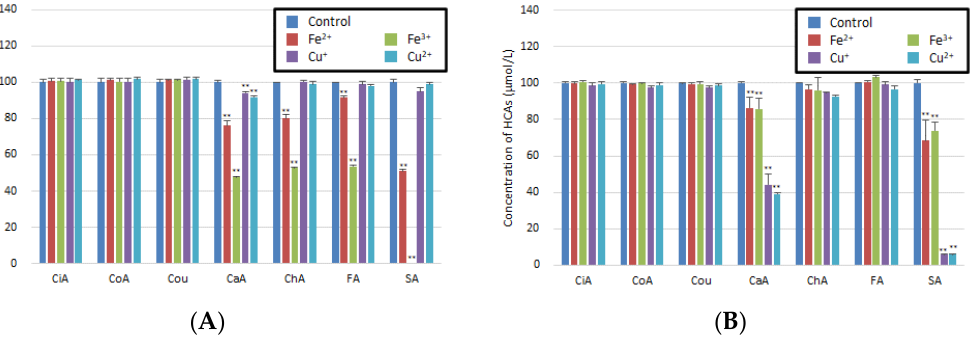
Figure 1. Interaction of HCAs with different metal ions (Fe 2+ , Fe 3+ , Cu + , or Cu 2+ ). ( A ) HCAs with metal ions in FaSSGF. ( B ) HCAs with metal ions in FaSSIF. Results are presented as the mean ± SD for three independent experiments. ** indicate significantly different values at p < 0.05 and p < 0.01, respectively.